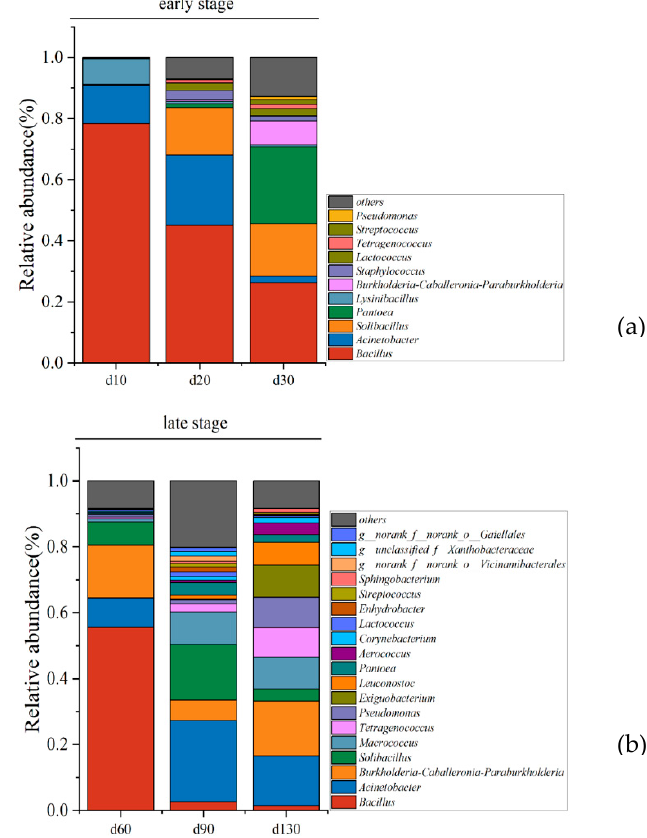
Figure 3. Bacterial community succession at the genus level in the early stage ( a ) and in the late stage ( b ).